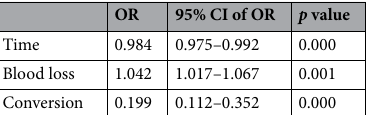
Table 3. Outcome, adjusted. OR odds ratio; CI confidence interval.